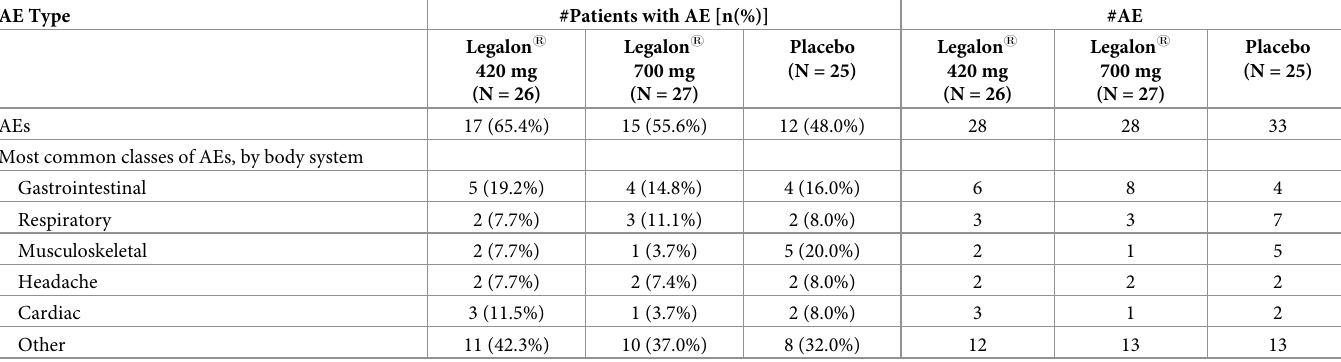
Table 4. Adverse events by treatment